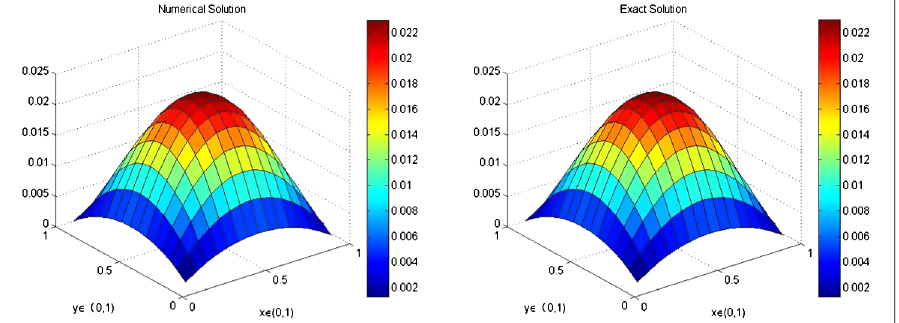
and τ = 1 in Example 2. 32 1024